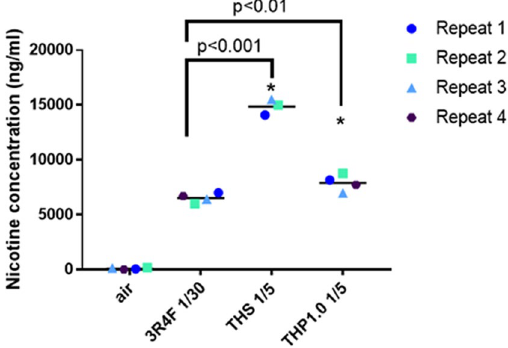
Figure 2. Nicotine quantification in the cellular media from exposure chambers. Scatter plot showing the nicotine concentration (ng/ml) quantified for each experimental repeat and per treatment. The values from independent run repeats are labelled with different colors. The mean nicotine value for each treatment is shown by the black horizontal line. * Denotes a t-test significance at p < 0.05 using 3R4F nicotine as